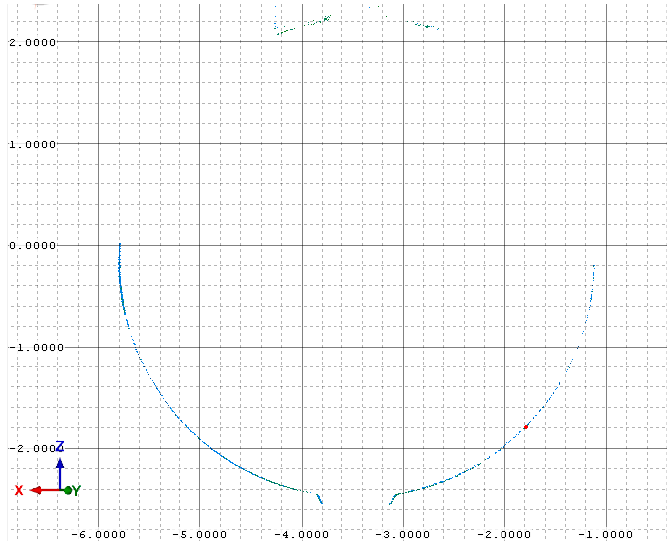
Figure 10. Cross section through the ship hull in meters.